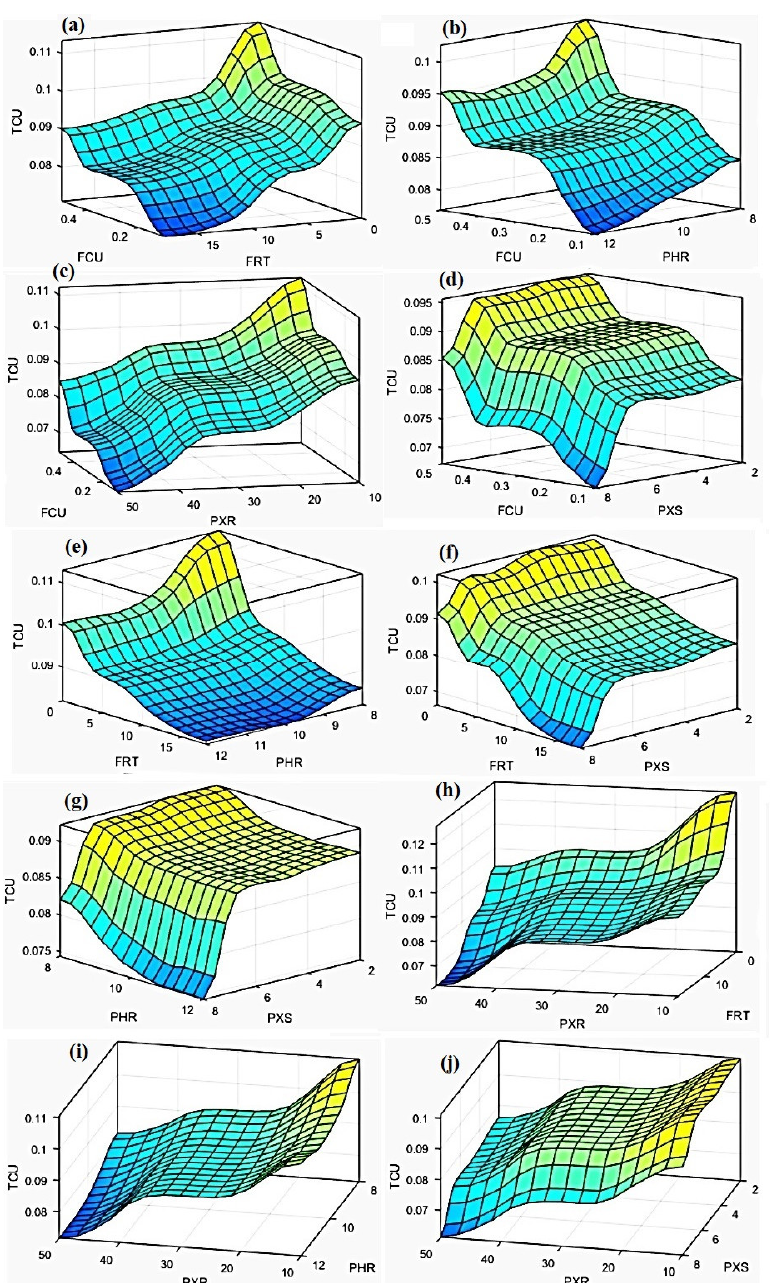
Figure 12. Resulting response surfaces of the PSM model—dependence of copper content in final tailings (TCU) on input parameters. ( a ) copper content in the feed (FCU) and frother consumption (FRT); ( b ) copper content in the feed (FCU) and pH value of slurry at rougher flotation circuit (PHR); ( c ) copper content in the feed (FCU) and collector consumption at rougher flotation circuit (PXR); ( d ) copper content in the feed (FCU) and collector consumption at scavenger flotation ciruit (PXS); ( e ) frother consumption (FRT) and pH value of slurry at rougher flotation circuit (PHR); ( f ) frother